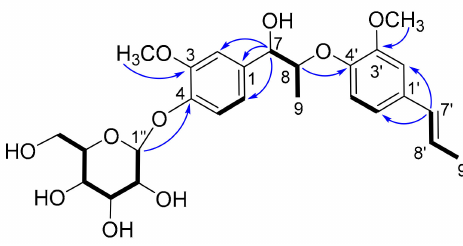
Figure 3. Key 1 H- 1 H COSY ( − ) and selected HMBC correlations (H → C) of 2 . (cid:48)(cid:48) The HMBC correlation from H-1 to C-4 indicated the hexose moiety was connected to